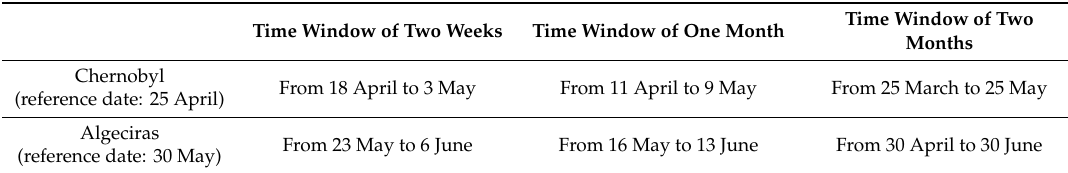
Table 1. Time windows defined for Chernobyl and Algeciras case studies to extract the end-point positions in the period 2007–2016. Time Window of Two Weeks Time Window of One